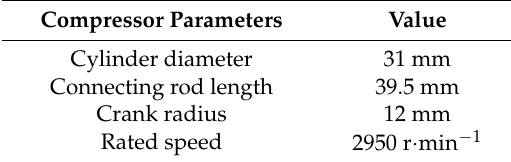
Table 1. Structural parameters of the refrigerator compressor.